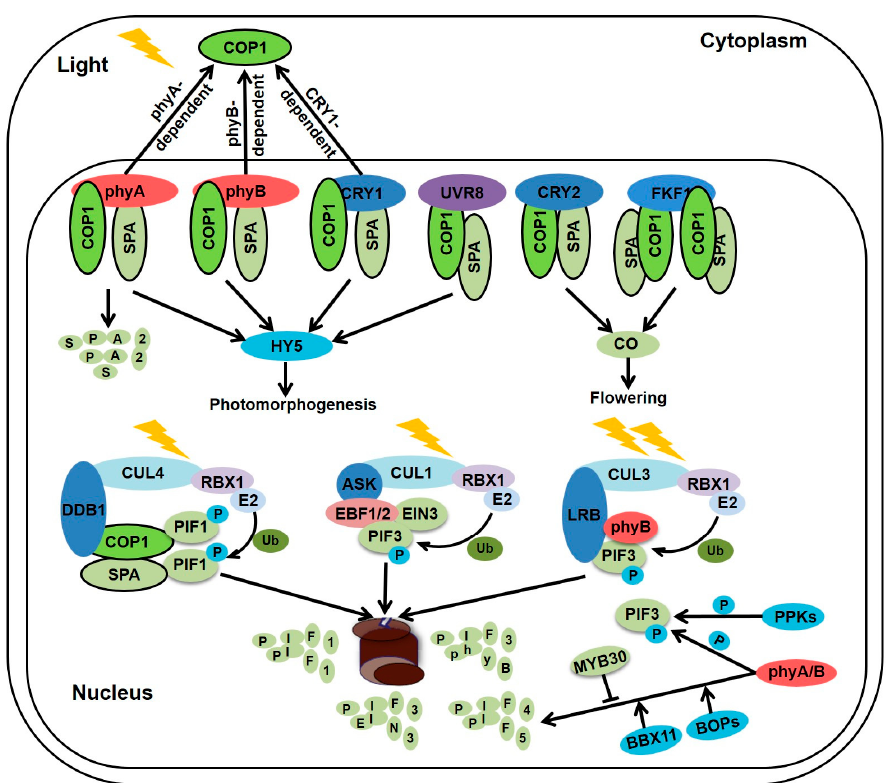
Figure 2. Light induces the inactivation or degradation of photomorphogenic repressors. Red/far- red light-activated phytochromes and blue light-excited CRY1 interact with SPA1 to disassociate COP1-SPAs complex, while blue light-excited CRY2 associates with SPA1 to enhance the interaction between COP1 and CRY2 which is a competitor of COP1 substrates. Light-activated FKF1 interacts with COP1 to inhibit COP1 dimerization. In the UV-B irradiation, UVR8 monomer which carries a VP motif competitively interacts with COP1 to release the traditional COP1 substrates. Besides, the phyA and COP1 dependent SPA2 degradation contributes to a decrease in the COP1-SPAs E3 ligase activity in the light. In addition, phytochromes and cryptochrome promote COP1 translo- cation from nucleus to the cytosol in continues light condition. CUL4-DDB1-COP1-SPAs complex promotes PIF1 phosphorylation and degradation. At the beginning of light exposure, plants sense weak light to promote PIF3 phosphorylation via phytochromes and PPKs. Phosphorylated PIF3 recruits EBF1/2 and CUL1 to form SCF EBF1/2 -PIF3 complexes, leading to the ubiquitination and degradation of PIF3. Under strong light treatment, CUL3 LRBs E3 ligase also triggers PIF3 degradation in addition to SCF EBF1/2 . It is worth to note that the CUL3 LRBs E3 ligases results in the degradation of both phyB and PIF3 to attenuate and balance plant light responses. Moreover, phytochrome A and phytochrome B promote PIF4 and PIF5 phosphorylation and degradation. MYB30 negatively regulates the reaccumulation of PIF4 and PIF5 under prolonged red light irradiation, whereas BBX11 positively controls PIF4 reaccumulation in the prolonged red